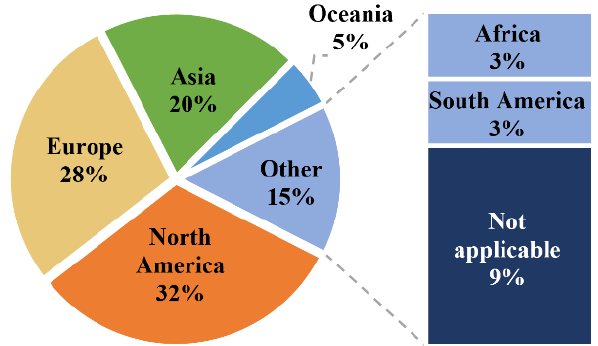
Figure 3. Arrangement of selected publications by region.